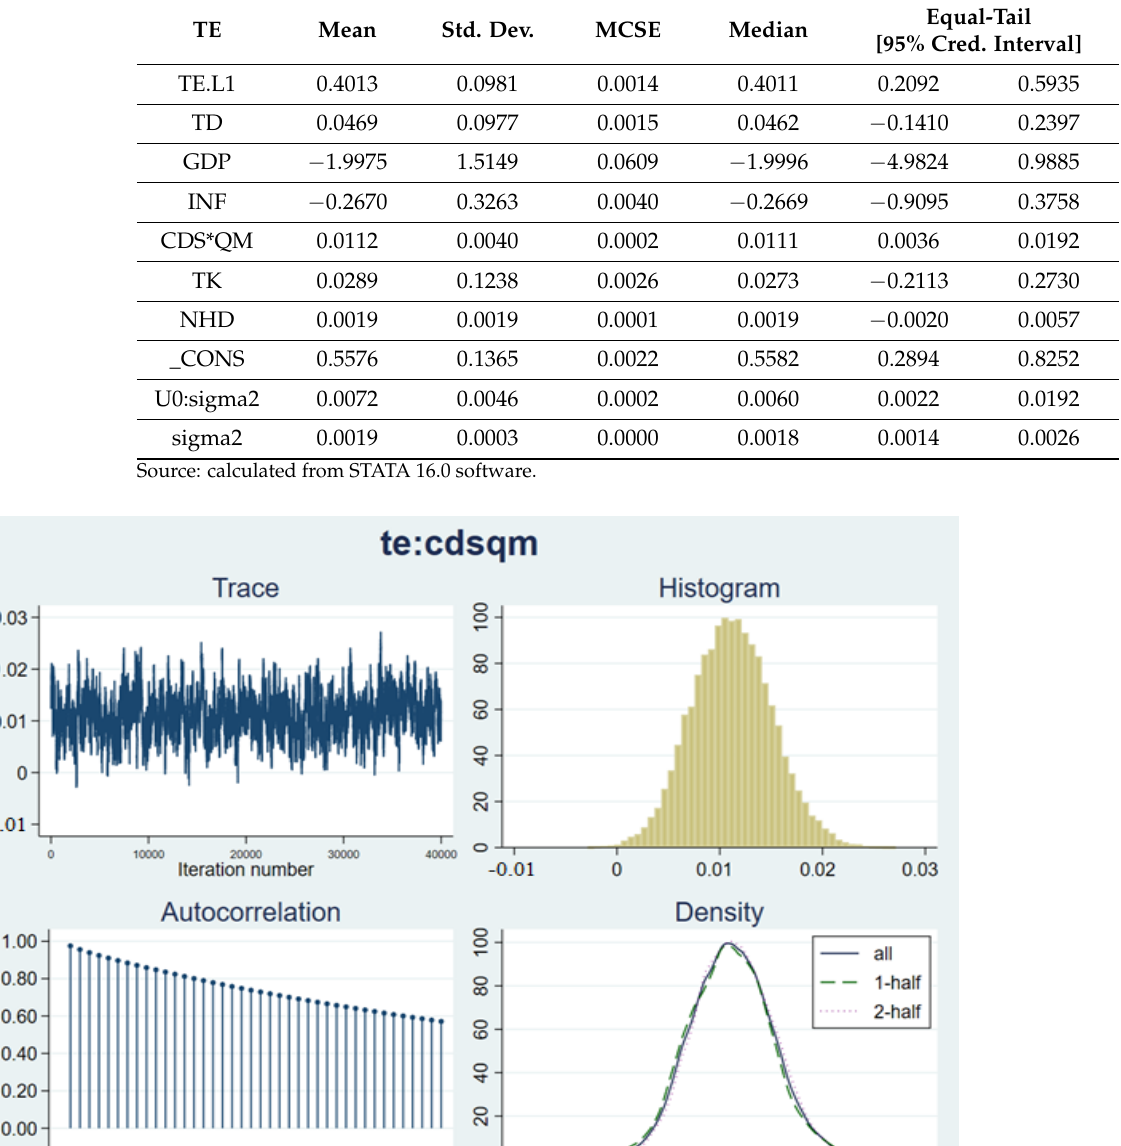
Table 6. The estimation result of Model (2) by the Bayesian method.